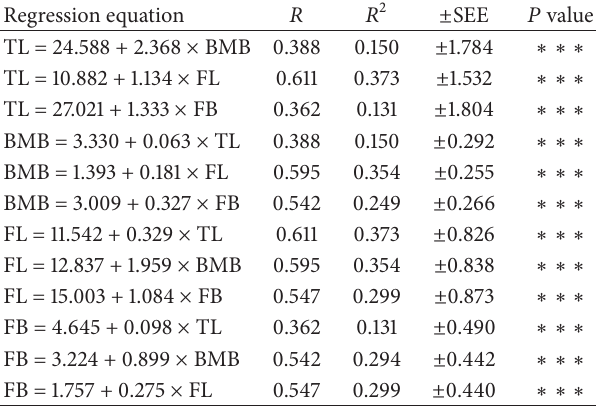
TL:tibiallength,BMB:bimalleolarbreadth,FL:footlength,FB:footbreadth, 𝑅 :correlationcoefficient, 𝑅 2 :coefficientofdetermination,andSEE:standard error of estimate. ∗ ∗ ∗ The 𝑃 value was significant at the 0.001 level